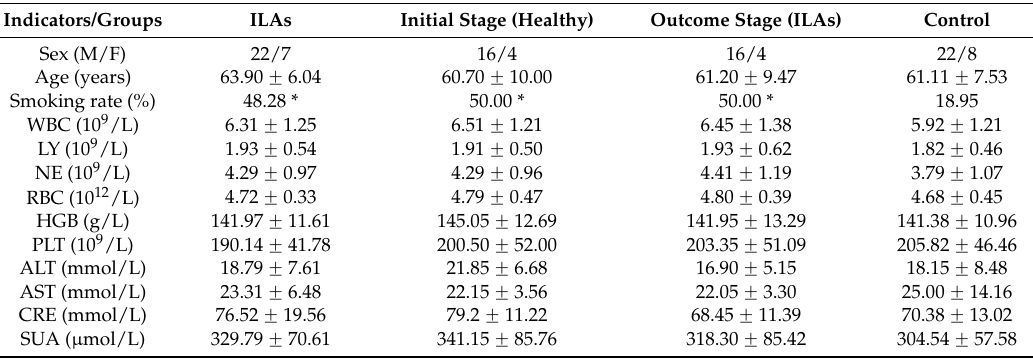
Table 1. Characteristics among the groups of the enrolled subjects.